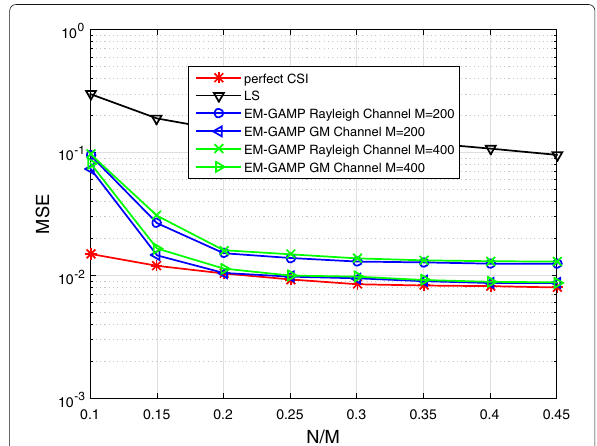
Fig. 4 MSE performance comparison of different channels and M as with SNR = 15 dB , L = 3, λ = 0.2 functions of N M